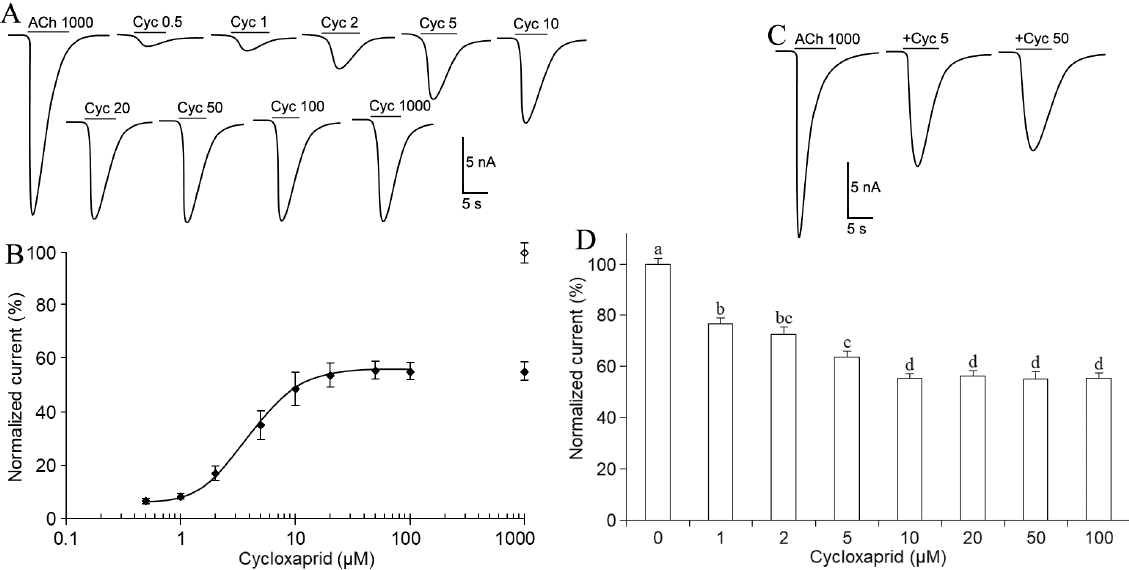
Figure 3. Cycloxaprid acted on cockroach DUM neurons as a partial agonist. ( A ) Representative currents elicited by acetylcholine and cycloxaprid on cockroach DUM neurons. The concentrations (µM) were provided above the currents following drug name, acetylcholine (ACh), and cycloxaprid (Cyc). ( B ) Concentration-response curve for inward currents induced by cycloxaprid ( n = 12). The currents were normalized to the maximum currents elicited by 1000 µM ACh, as indicated by the blank diamond ( ◊ ). A separate fi lled diamond ( ♦ ) showed the normalized currents from 1000 µM Cyc. ( C ) Representative currents elicited by the application of ACh and co-application of ACh and Cyc on cockroach neurons ( n = 15). Concentrations were provided following drug names. + meant ACh plus Cyc. ( D ) Cyc concentration-dependent inhibition on inward currents elicited by 1000 µM ACh on cockroach neurons ( n = 14–20). The currents were normalized to the maximum currents elicited by 1000 µM ACh. Data were presented as mean ± SEM. We performed one-way ANOVA with Tukey’s multiple comparisons. Di ff erent le tt ers indicated signi fi cant di ff erences at 0.05 level.